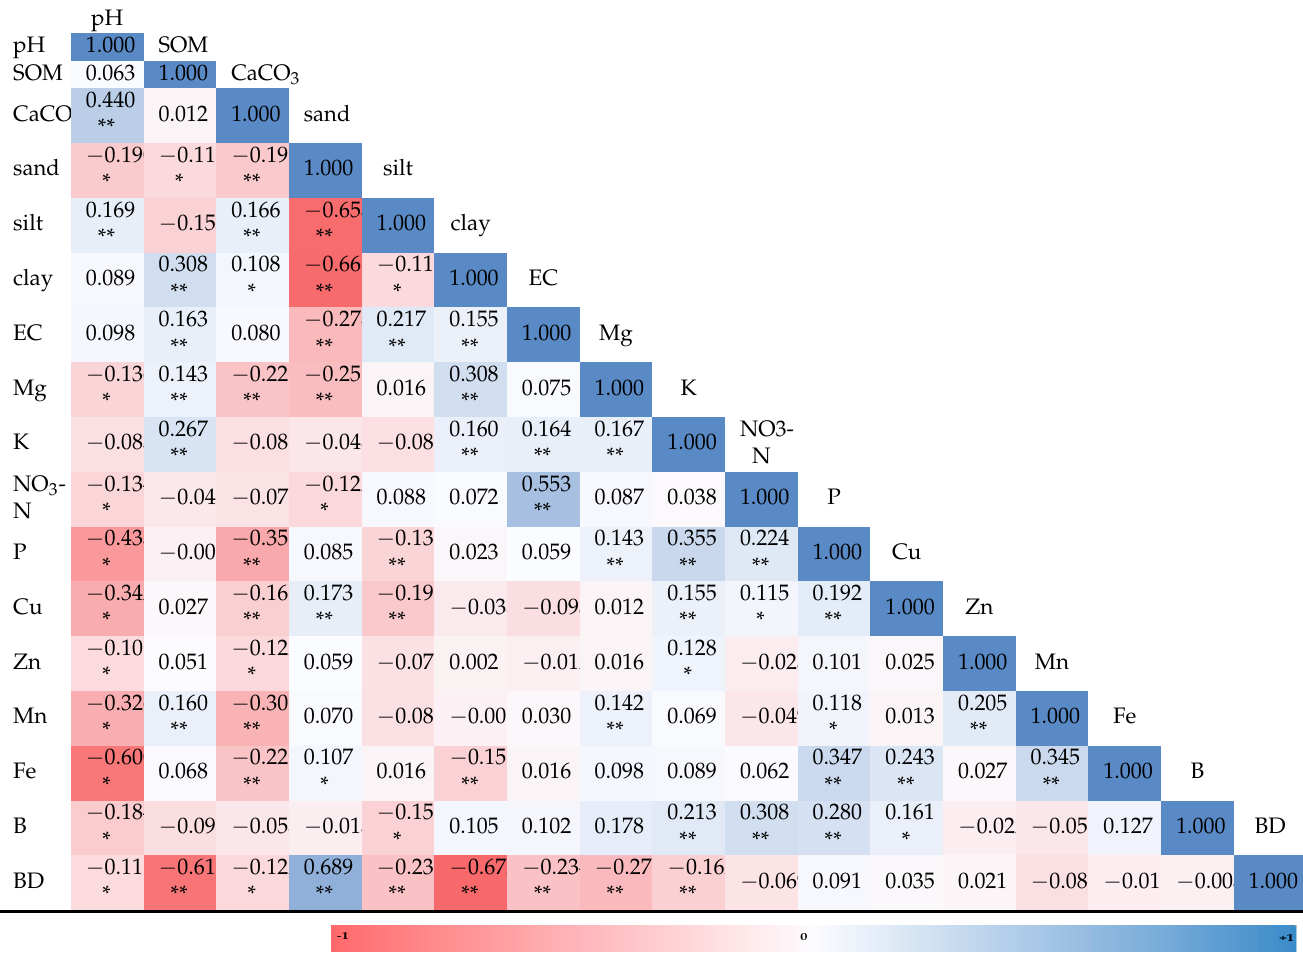
Table 2. Correlation matrix based on Pearson’s correlation coefficients between soil chemical and physical properties in total study area ( Stotal ).